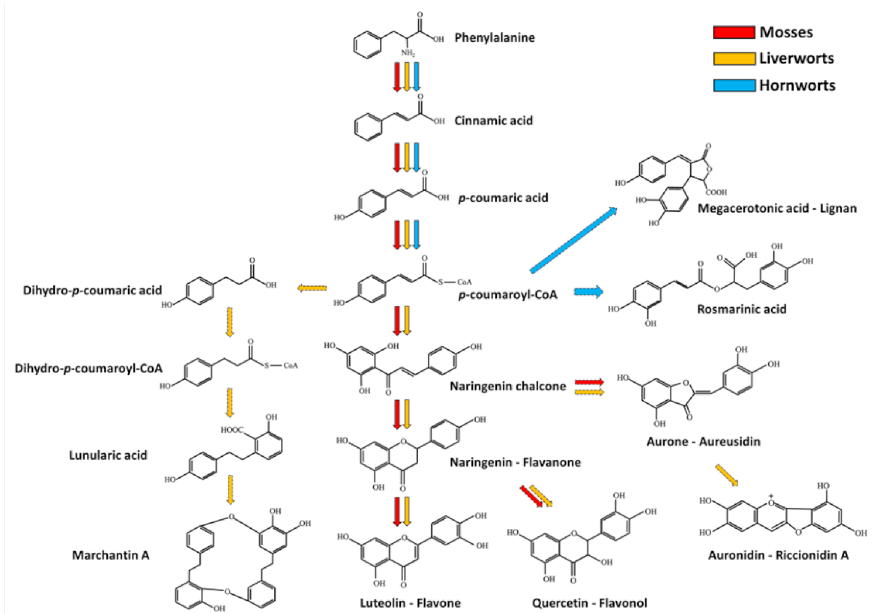
Figure 2. Simplified phenylpropanoid pathway and some of its putative branches in bryophytes. Red, orange and cyan arrows indicate the metabolic fluxes observed in mosses, liverworts and hornworts respectively, as suggested in various reports (see references in the main text). Dashed arrows indicate multiple reaction steps between the precursor and